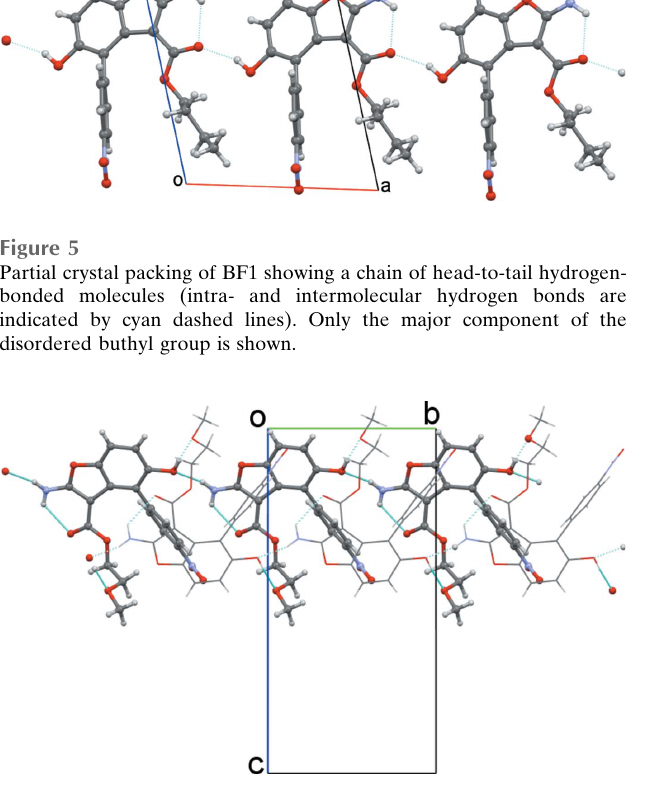
Figure 6 Partial crystal packing of BF2 showing two head-to-tail hydrogen-bonded chains connected by O—H (cid:3)(cid:3)(cid:3) O methoxy hydrogen bonds (the deeper chain is drawn in capped stick style; intra- and intermolecular hydrogen bonds are indicated by cyan dashed